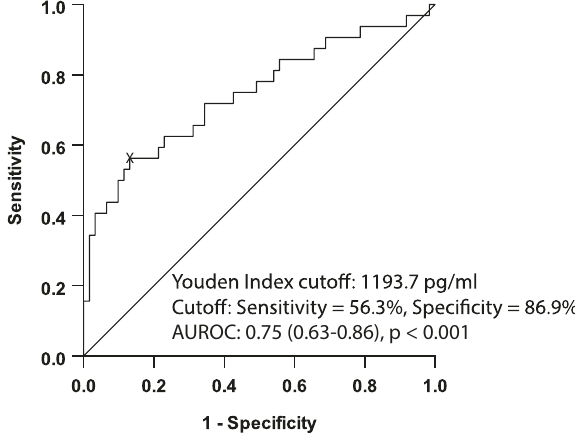
Fig. 2 Receiver-operating characteristic curve of serum GDF-15 concentrations for ≥ F2 fi brosis ( ≥ 8.2 kPa as measured by VCTE). Sample size n =